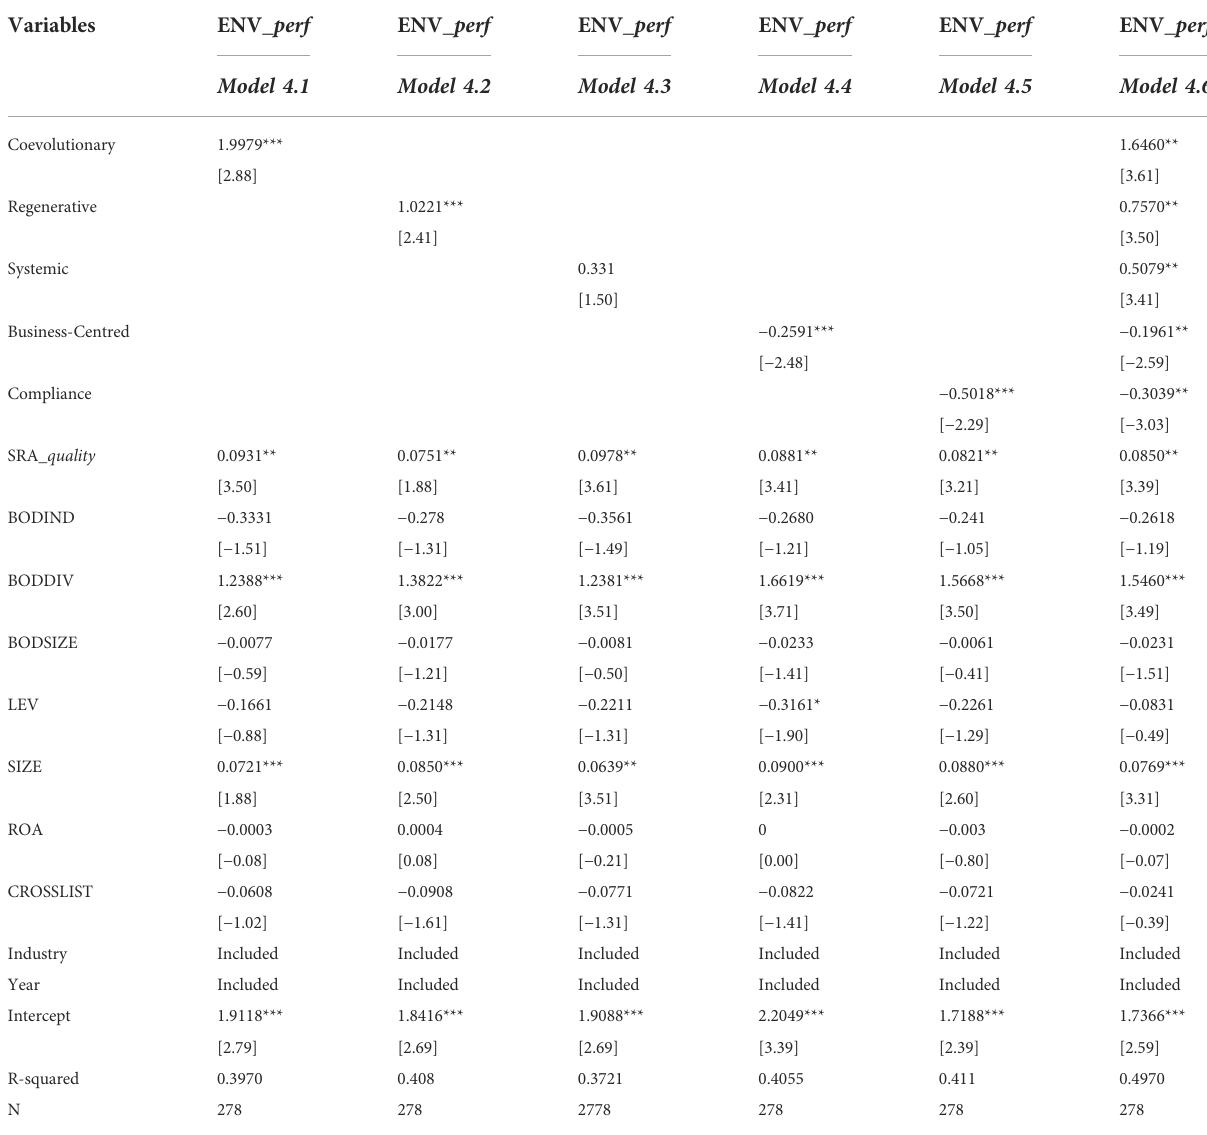
TABLE 4 Impact of sustainability communicative actions on environmental